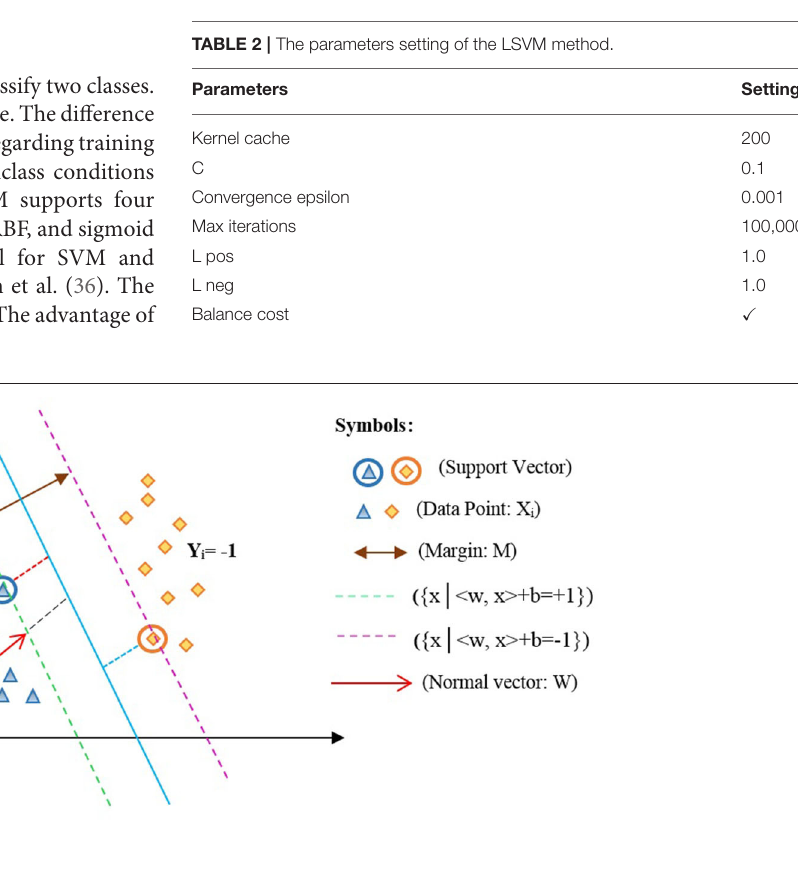
FIGURE 2 | Optimized hyperplane for two-dimensional